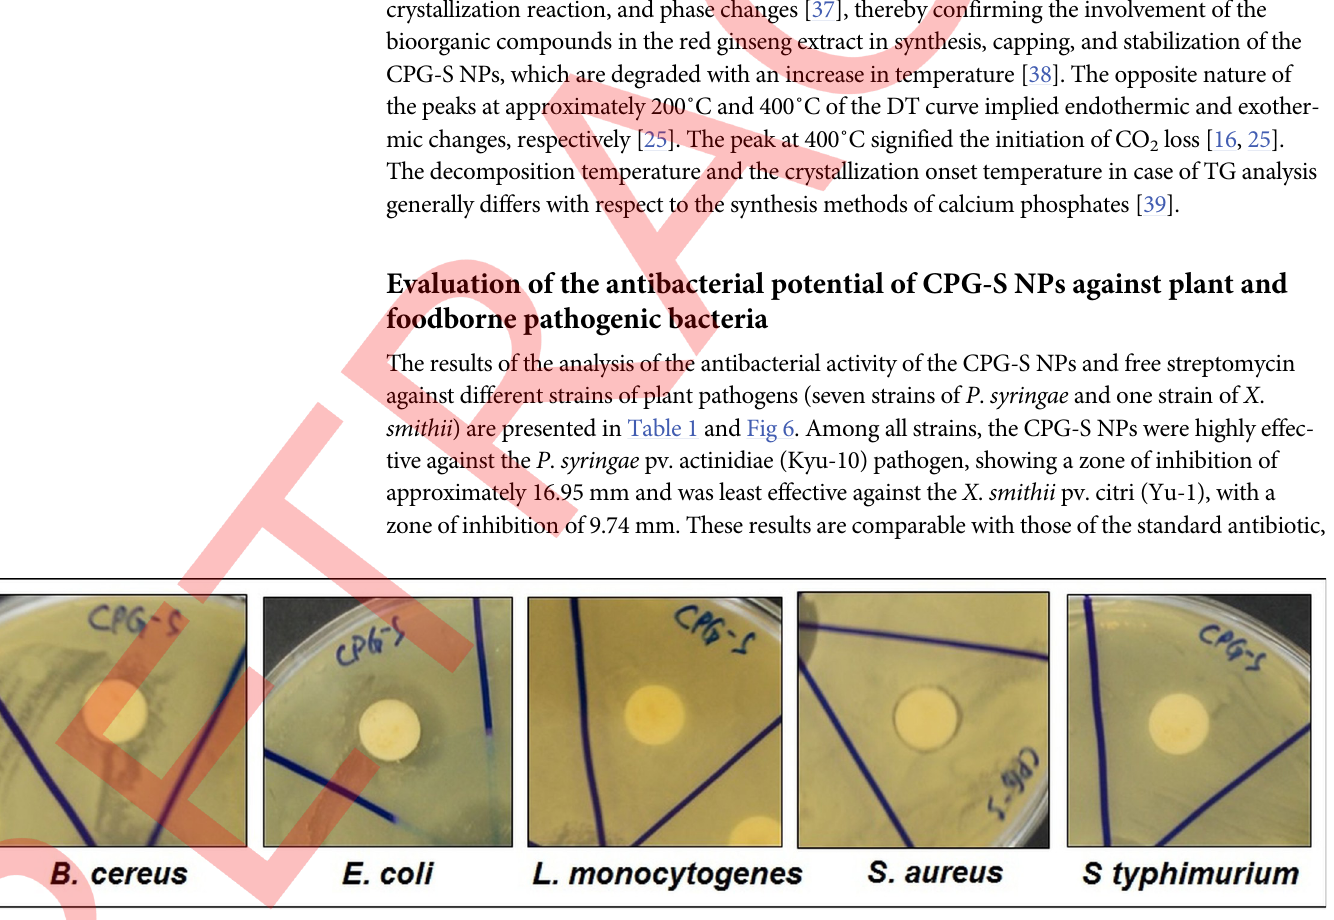
Fig 7. Antibacterial activity of CPG-S NPs against the five different foodborne pathogenic bacteria.